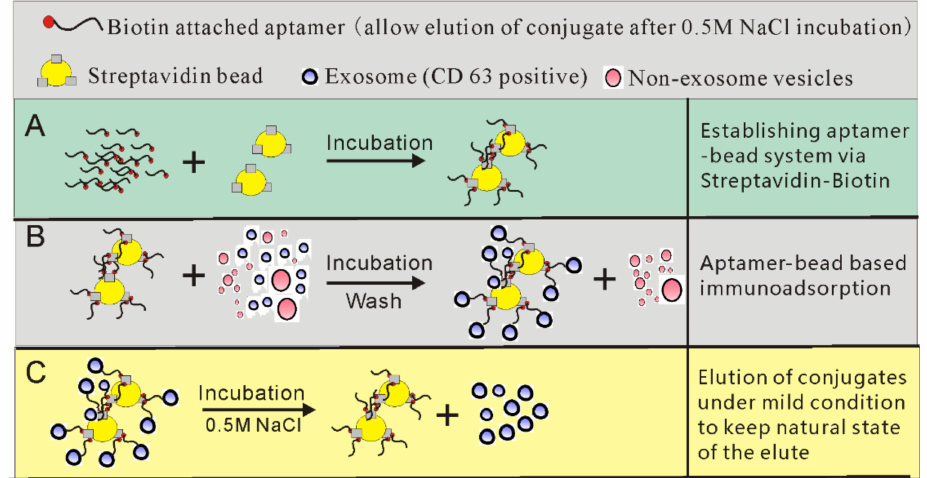
Figure 6. A schematic of the establishment of a bead / aptamer system for native exosome isolation. ( A ) Synthesizing 3 (cid:48) biotinylated CD63-1 aptamer and incubating with streptavidin magnetic beads